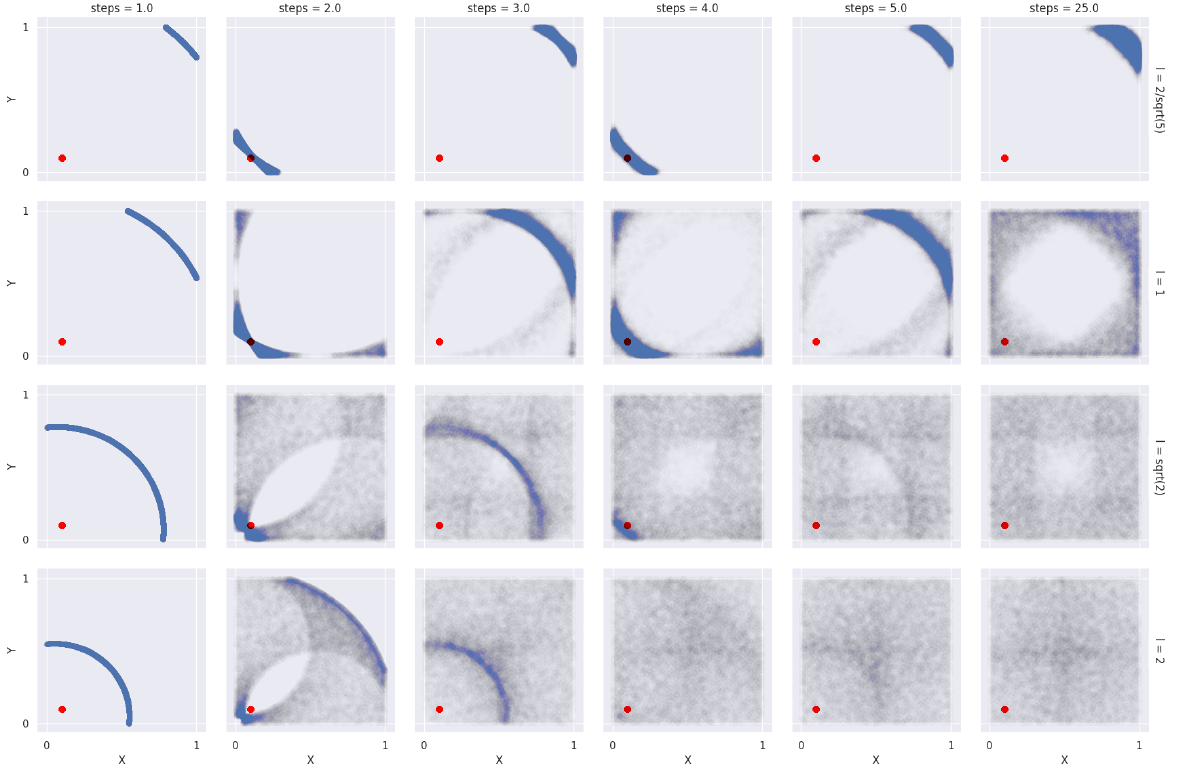
Figure 4: The distribution of the location after a small number of steps (columns, s = 1 , 2 , 3 , 4 , 5 , 25) in different size squares C 2 ( l ) (rows, l = 2 / is estimated using 20000 independent Monte-Carlo simulations of the process, starting in the point (0 . 1 , 0 . 1) (red). The squares are all scaled to size one, so that the ‘unit’ steps are of different